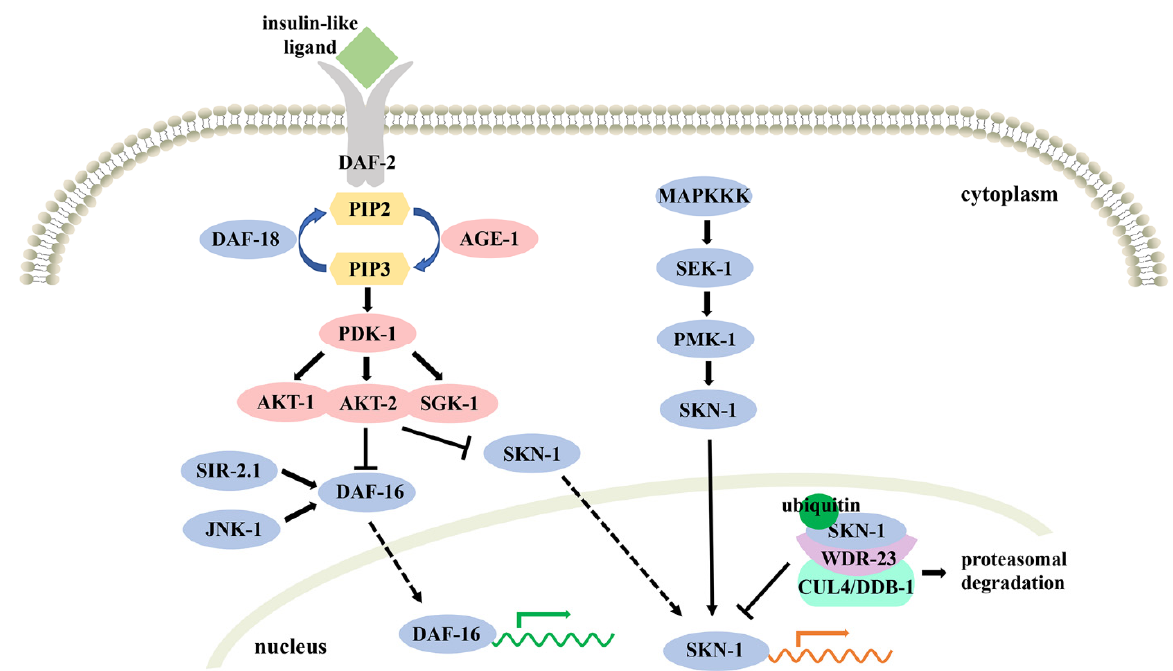
Figure 2. Schematic diagram of the IIS and SKN-1/Nrf2 pathways in C. elegans .